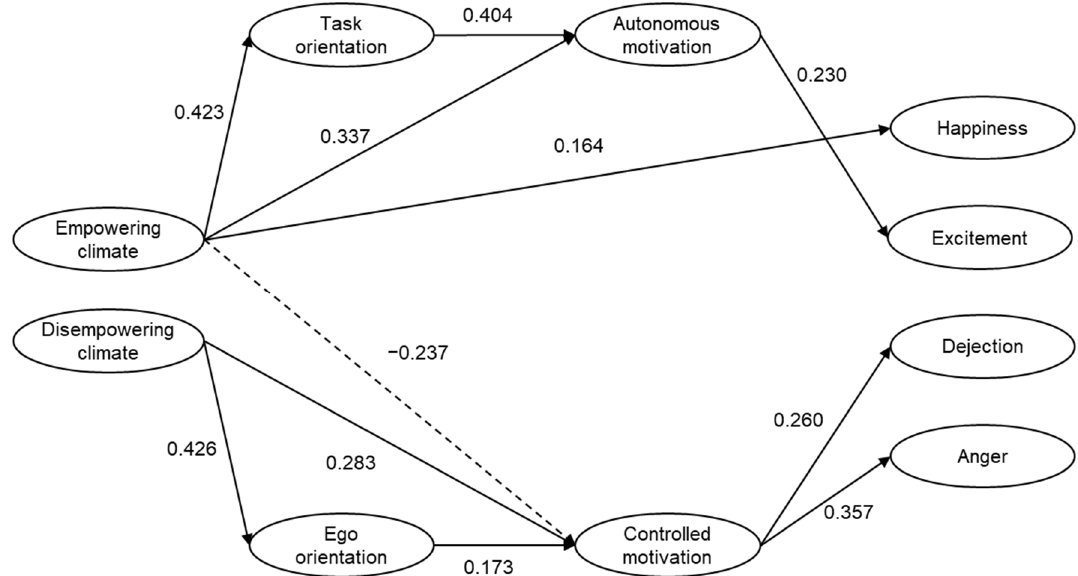
Figure 1. Structural equation model illustrating interrelationships between perceived motivational climate, goal orientations, motivation regulations, and emotions. Significant standardized estimates are presented ( p < 0.05). Anxiety is not depicted as no significant direct paths emerged.